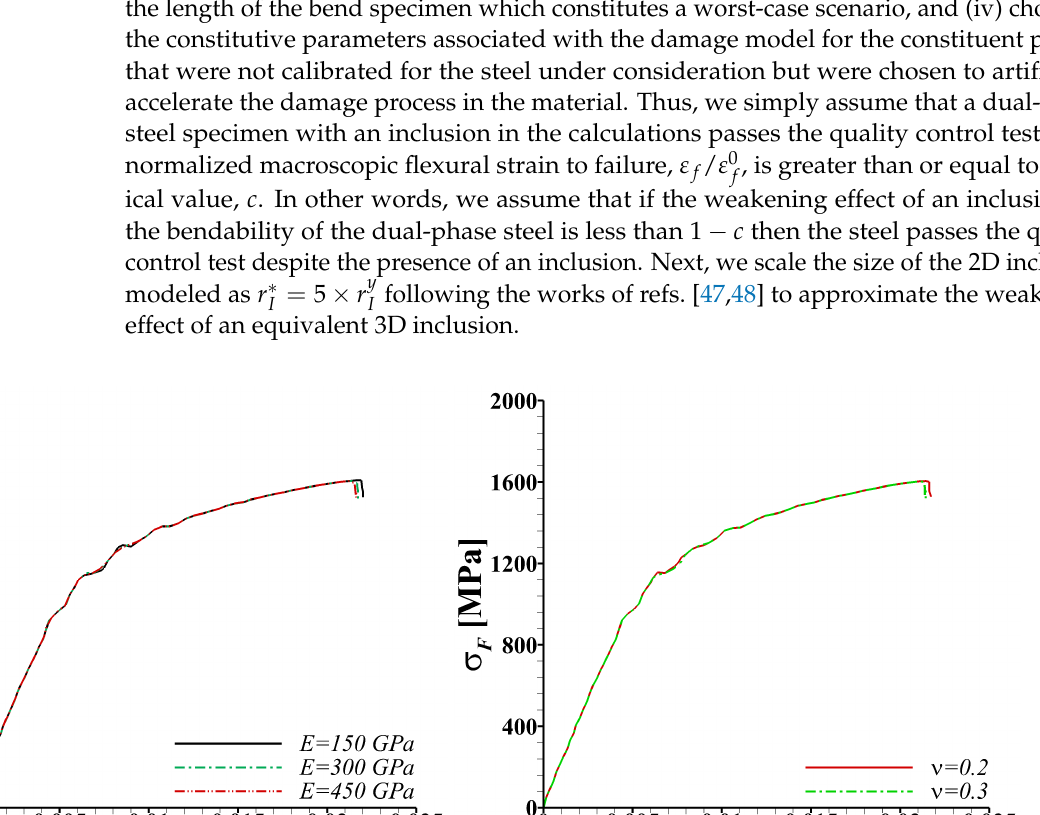
F )-strain ( ε F ) response of the dual-phase